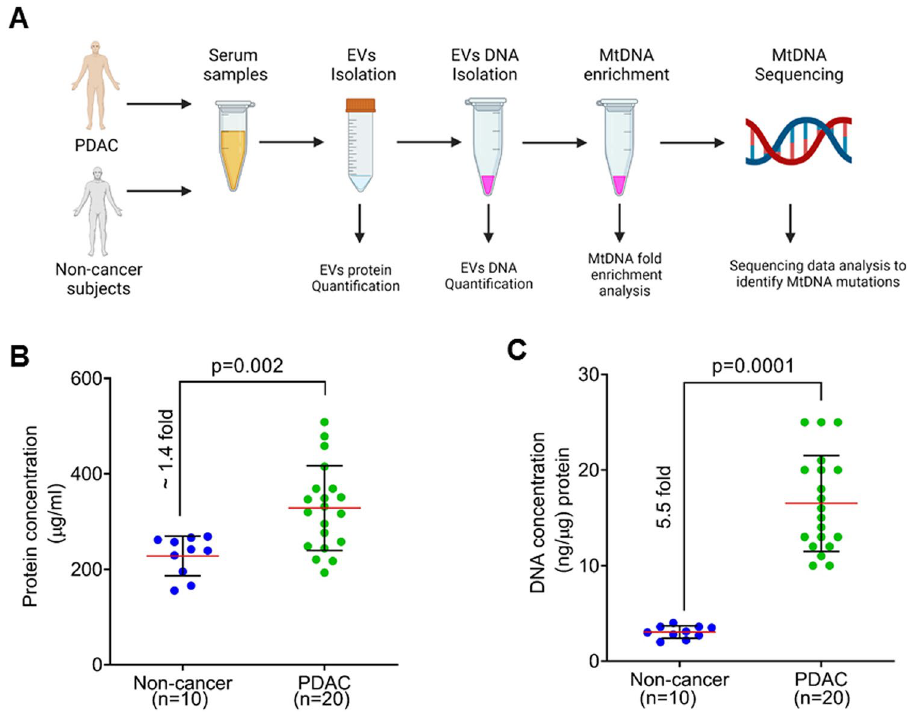
Figure 1. Isolation of extracellular vesicles and measurement of protein and total DNA content. ( A ) Workflow depicts steps undertaken to analyze the serum from pancreatic ductal adenocarcinoma (PDAC) patients and non-cancer subjects to analyze extracellular vesicles (EVs). Figure was generated using BioRender software. ( B) EVs were isolated from non-cancer (n = 10) and PDAC (n = 20) subjects using a commercial kit, and protein concentration was determined as a measure of circulating EV yield. ( C) Genomic DNA was isolated using an equal amount of total EV from PDAC and non-cancer individuals, and its levels were measured using a Qubit 4 fluorimeter (Thermofisher). EVs: Extracellular vesicles; gDNA: Genomic DNA; mtDNA: mitochondrial DNA; PDAC: Pancreatic ductal